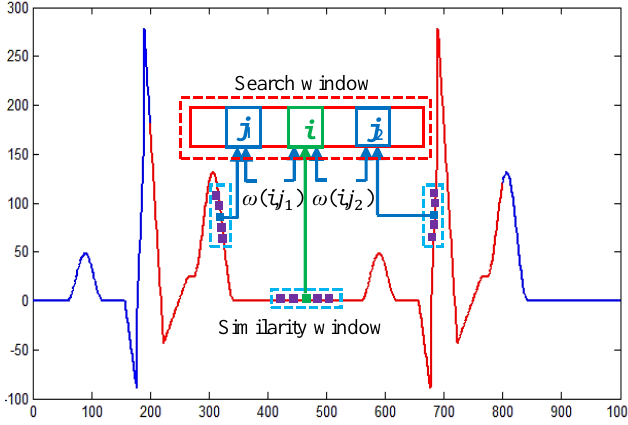
Figure 2. The principle of the NLM method.